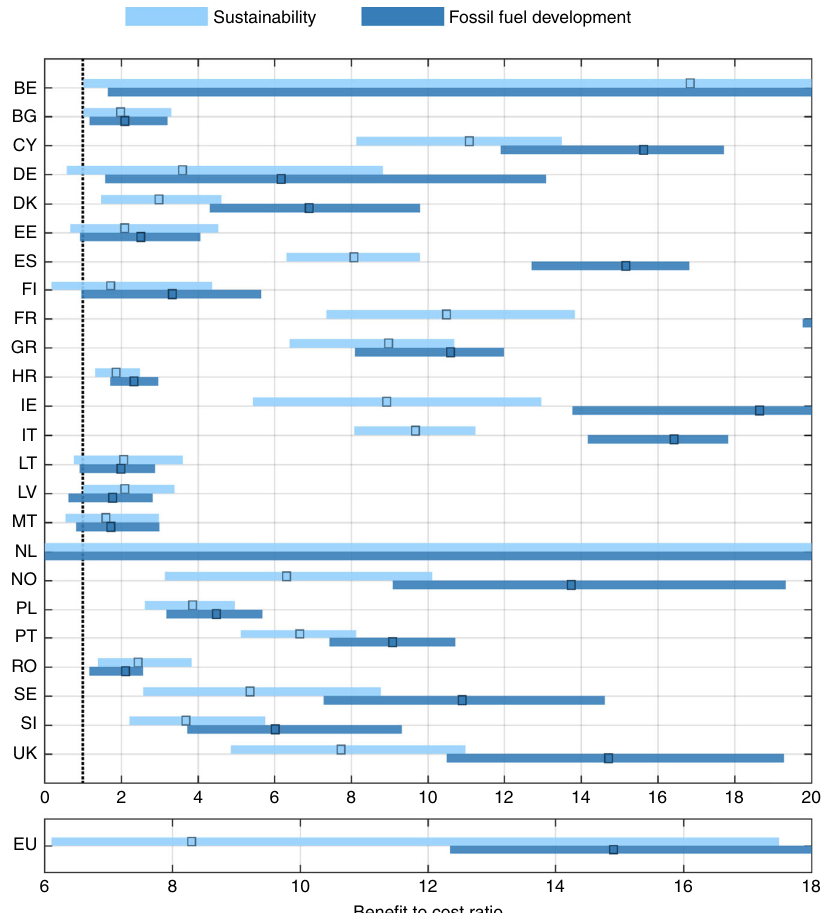
Fig. 2 Bene fi ts vs Costs at country level. Each colour expresses a scenario (Sustainability – RCP4.5 (light blue) and fossil fuel based development – RCP8.5 (dark blue)), with patches expressing the very likely range and squares the expected BCR per country. The vertical black dotted line expresses BCR =